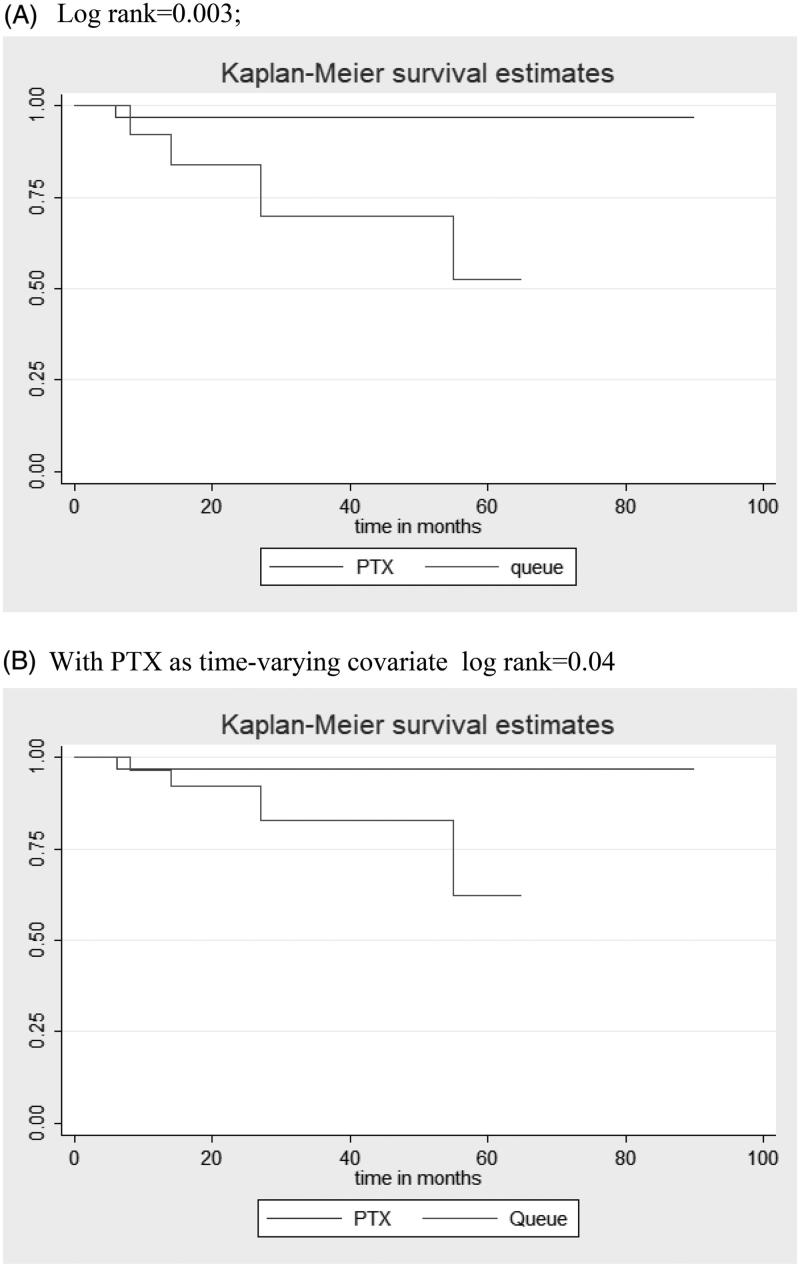
Kaplan–Meier curves. (A) Log-rank = 0.003; (B) With PTX as time-varying covariate log rank = 0.04.